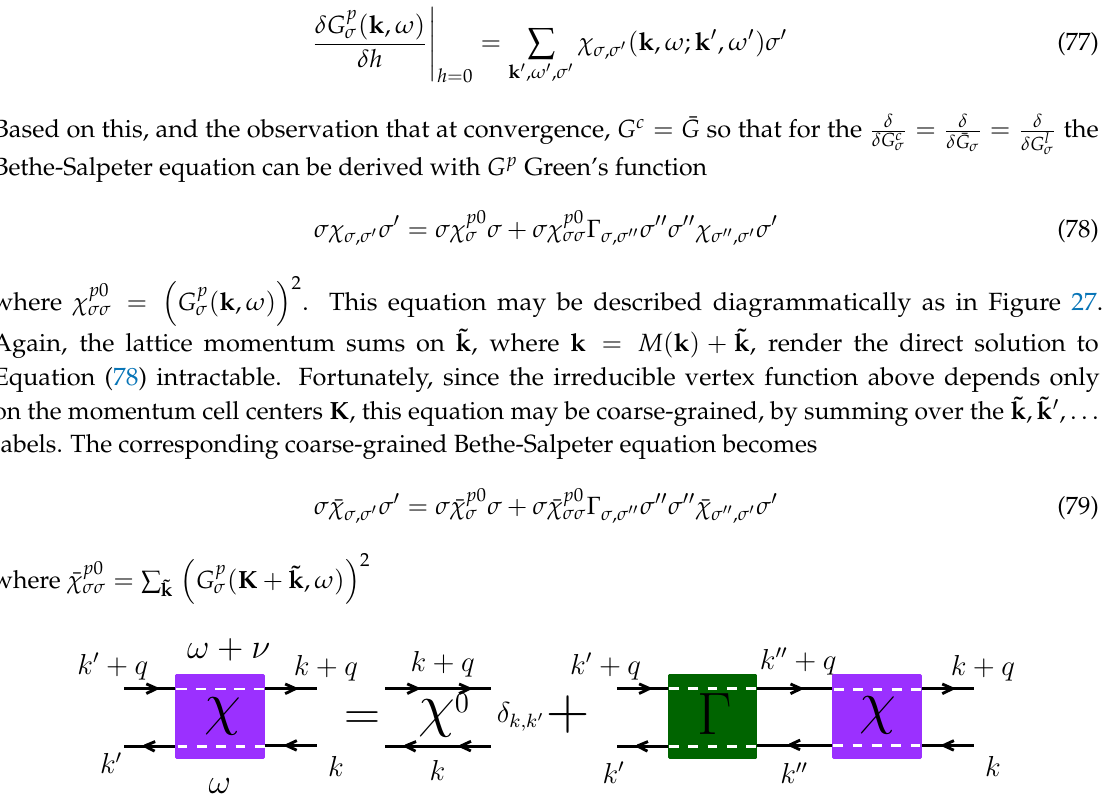
Figure 27. Bethe-Salpeter equation relating the two-particle Green’s function χ and the irreducible vertex Γ . While k , k (cid:48) and q represent momentum indices, ω and ν represent frequency indices (for fermionic and bosonic frequencies respectively) and the spin indices are suppressed. Please note that for the disordered systems considered here, the scatterings are elastic and thus the energy is conserved following any fermionic Green’s function line. Therefore, we only need two frequency indices to represent the frequency degree of freedom of the